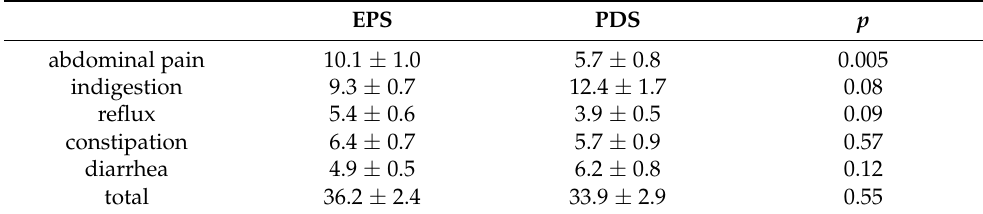
Table 2. Gastrointestinal symptom rating score in the patients.